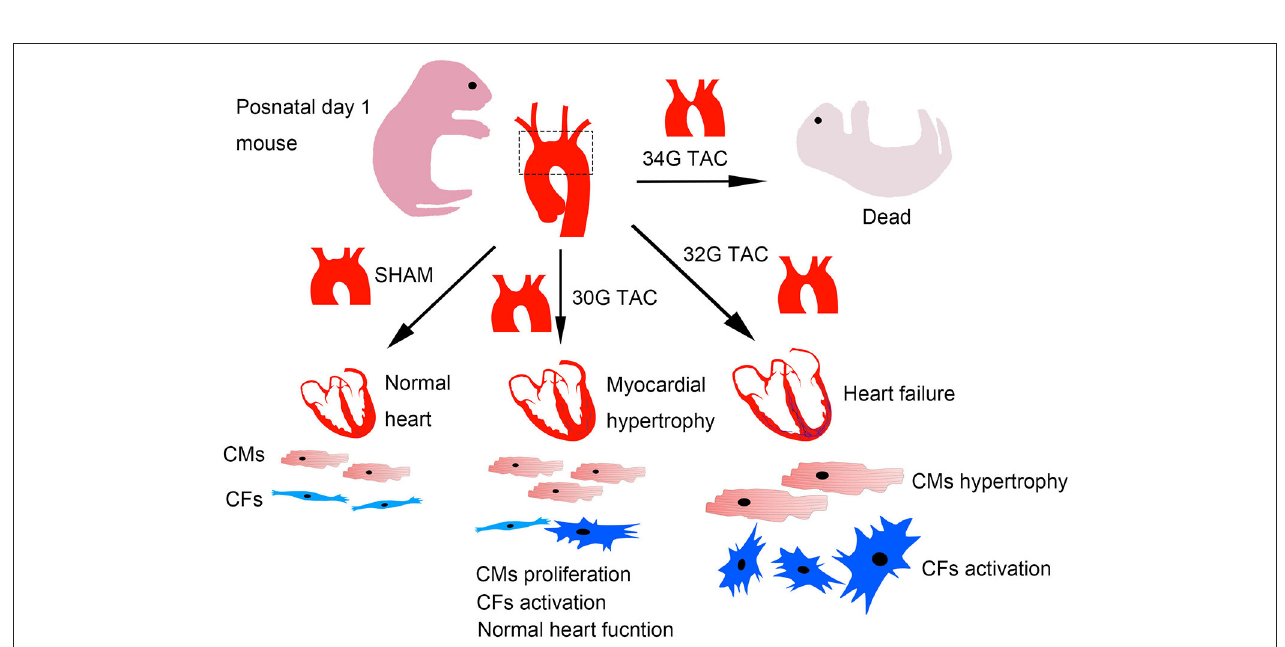
FIGURE 9 | Graphical diagram of the consequences of different pressure overloads in neonatal mice. Cardiomyocytes were effectively stimulated to proliferate under mild pressure overload with a reserved heart function. Moderate heart pressure overload caused cardiomyocyte hypertrophy and fibrosis, further influencing cardiomyocyte proliferation and heart function. The mice barely survived after severe pressure